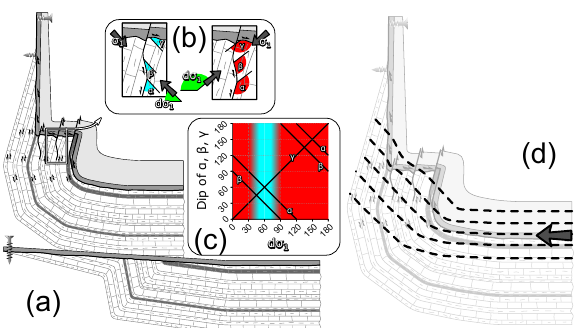
Figure 7. (a) Scheme showing the present-day geometry of the frontal limb of the Sant Corneli-Bóixols anticline (upper part), the geometry of the unconformity, and the pre- and syn-folding strata before folding (lower part). (b) Details showing the structural as- semblages observed at the Remolina anticline, with two alternative configurations for the maximum stress orientation. The maximum stress forms the following clockwise angles: dσ 1 with the horizon- tal, γ with the unconformity, α with the bedding-parallel steps of flexural-slip faults in the Vallcarga Group, and β with the oblique to bedding strands of the flexural-slip fault in the Vallcarga Group. Red and cyan colours indicate angles not compatible and compat- ible with the observed slip pattern respectively. (c) Relationships between dσ 1 and α , β and γ , with the red area indicating the ori- entation of the maximum stress not compatible with the slip pattern observed at the Remolina anticline. (d) Inferred maximum stress trajectories during the late stages of